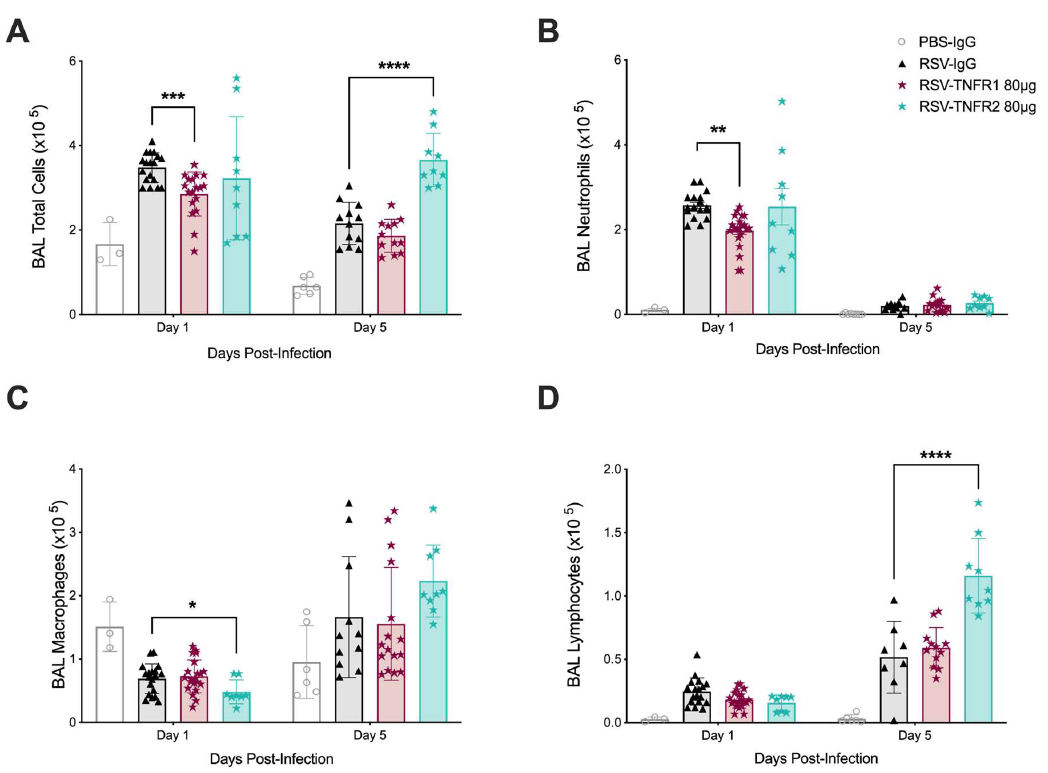
Figure 3. Blockade of TNFR1 reduces neutrophil number in the BALF of RSV infected mice. At day one and five p.i., BALF was collected and used to obtain ( A ) total cell counts, as well as di ff erential cell counts consisting of ( B ) neutrophils, ( C ) macrophages, and ( D ) lymphocytes. Data for RSV-TNFR1 are pooled from at least four independent experiments for each time point. Data for RSV-TNFR2 are pooled from at least two independent experiments for each time point. All data are expressed as mean ± SD. Significant results as compared to the respective control are marked with asterisks (* for p ≤ 0.05, ** p ≤ 0.01, *** p ≤ 0.001, **** p ≤